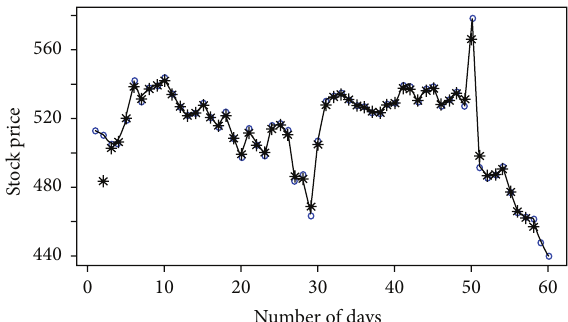
Figure 1: Opening price data (represented by hollow circles) and data fitted through Kalman filter model (represented by ∗ ). Original data points are joined by straight lines.